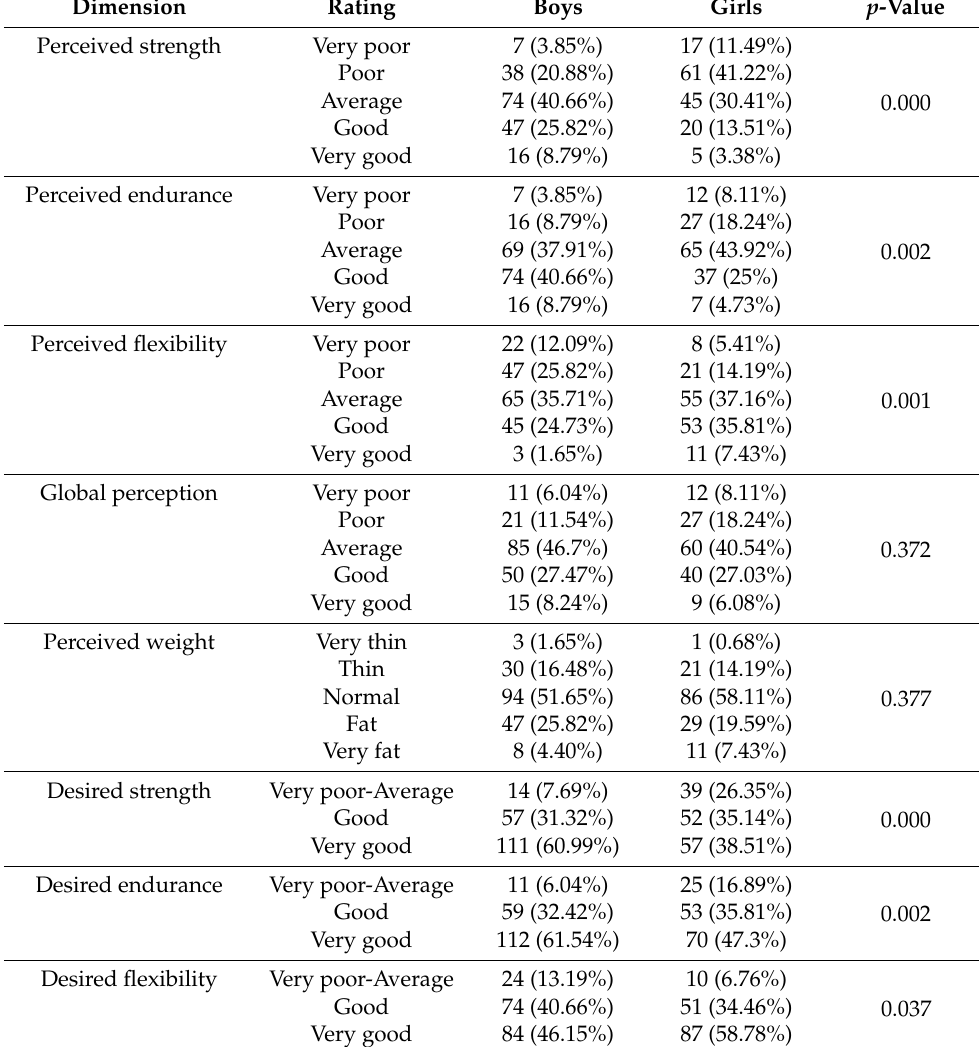
Table 1. Distribution for both boys and girls of the total and partial scores of the SPHQ-C. Dimension Rating